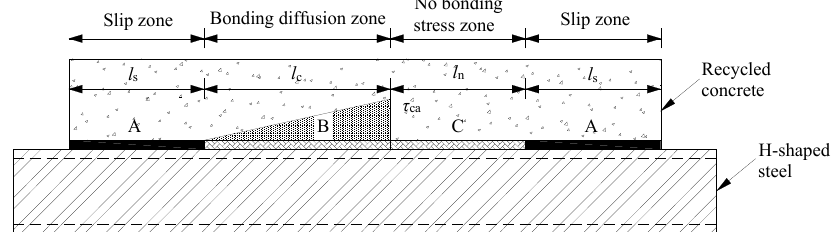
Figure 11. Division of the bonding interface.